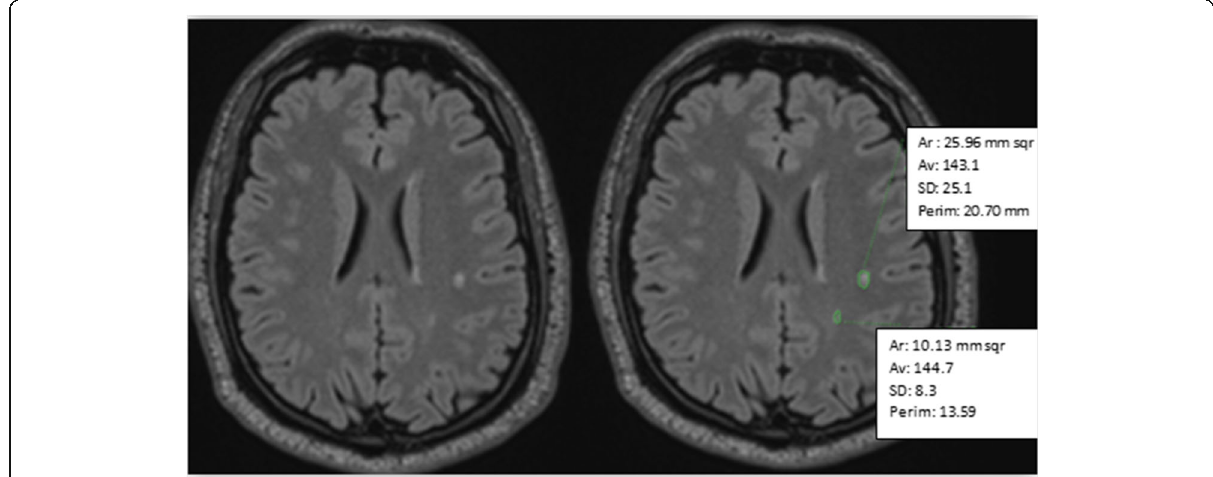
Fig. 1 Axial 3D FLAIR section showing two right cerebral demyelinating lesions (left). Manual tracing of the lesions with automatic calculation of their areas